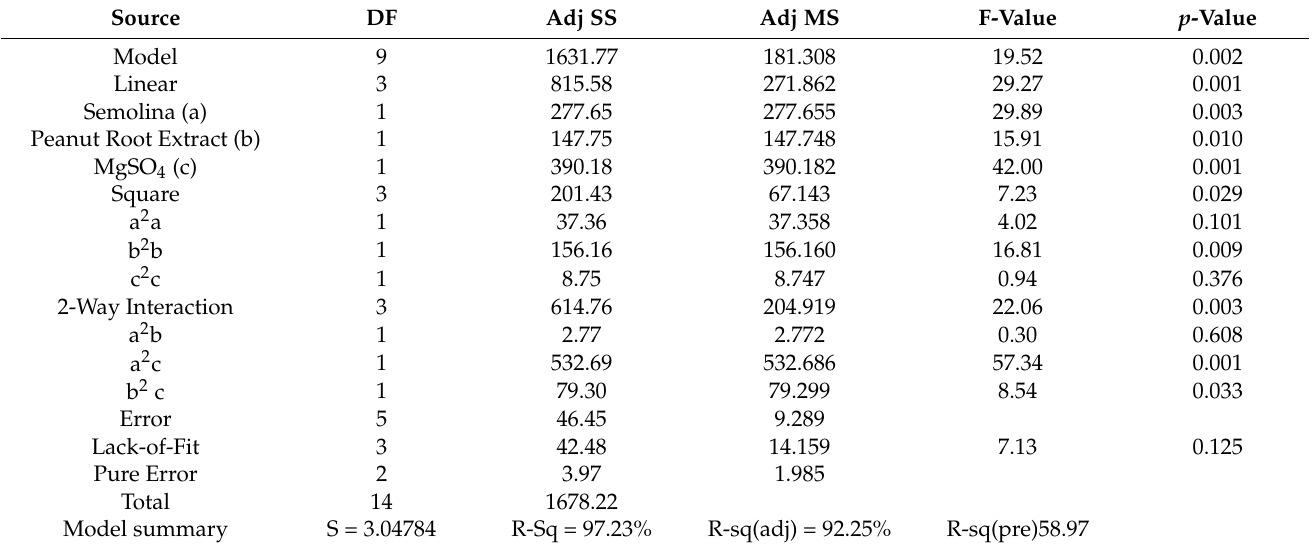
Table 2. Analysis of variance of antifungal activity against P. arachidicola